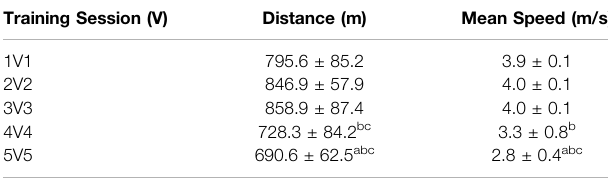
TABLE 1 | The normality of the distribution of the fi ve measurements. Measures